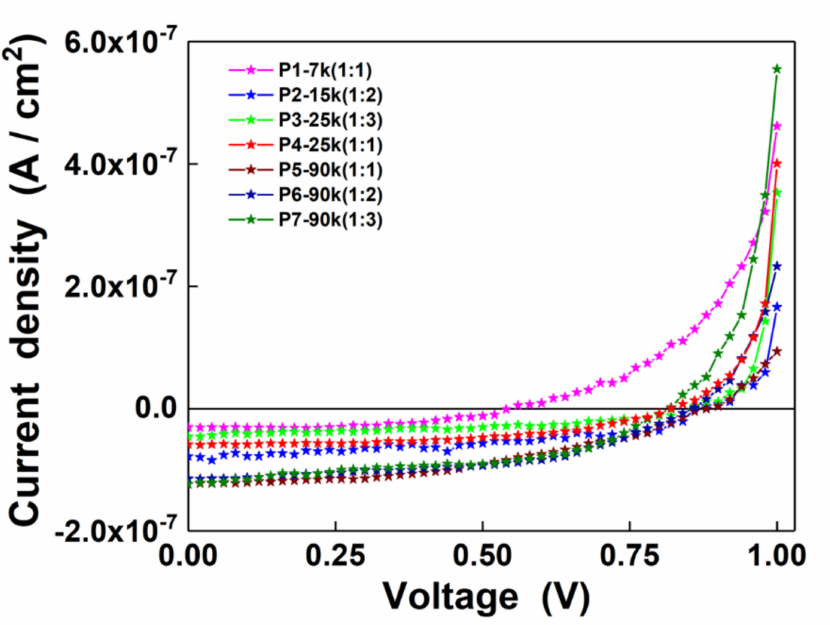
Figure 7. J-V characteristics of the structures developed on the thin films based on DPP-DTT:C60 blends deposited by